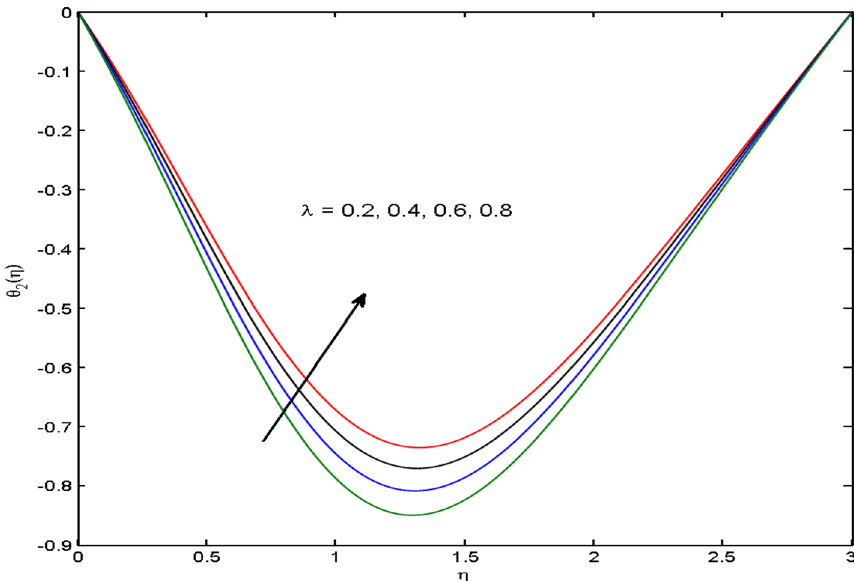
Figure 7. θ 2 (η) versus varied estimates of (cid:31) .